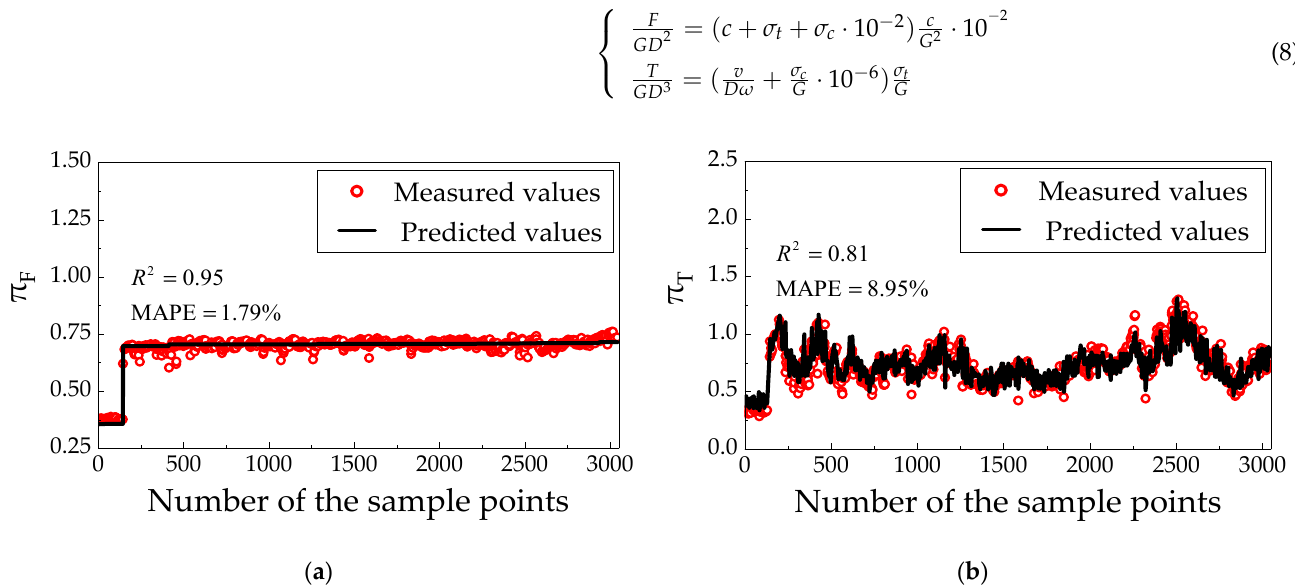
Figure 9. Comparison between the predicted values and the measured values of the dimensionless load models: ( a ) the total thrust, ( b ) the total torque.